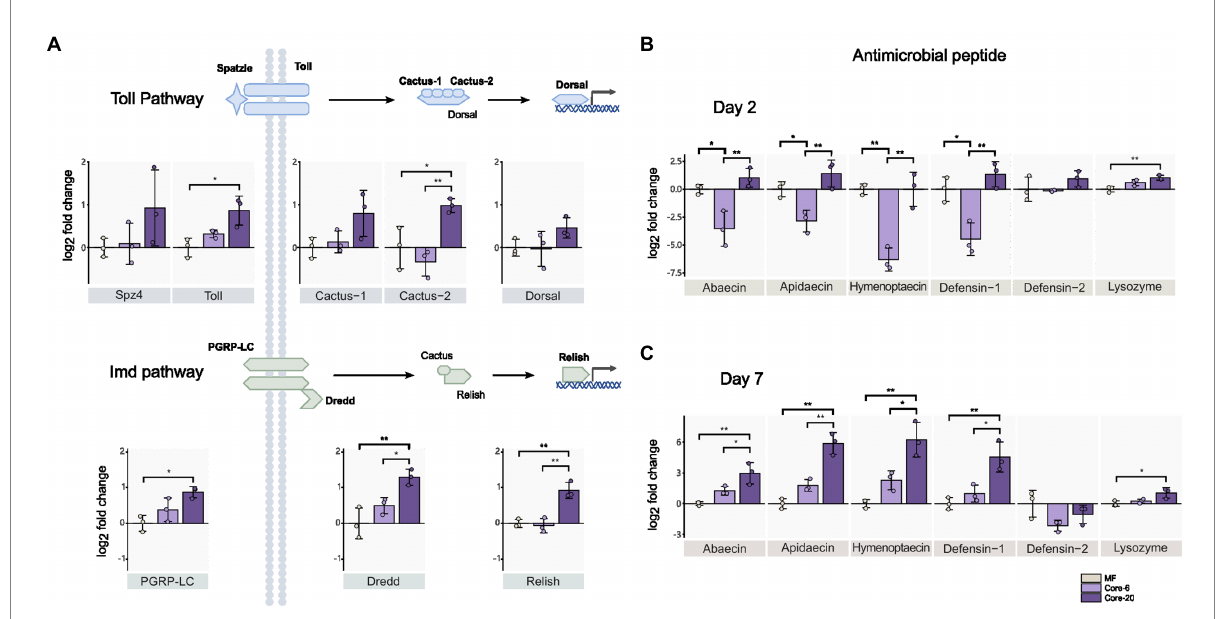
FIGURE 3 Core-20 triggers host immune gene expression in Imd and Toll pathways (A,B) at 24 h post-colonization and (C) 7 days post-colonization. The Core-20 displayed a significant promotion in regulators of the Toll and Imd pathways on Day 2 and potential ongoing upregulation in AMPs expression on Day 7. Besides, the Core-6 significantly reduced the expression of AMPs on Day 2. All results indicated that the gut microbiota could stimulate the host’s innate immune system. Gene expression was normalized relative to the housekeeping gene actin . * p < 0.05; ** p < 0.01 (Tukey honest